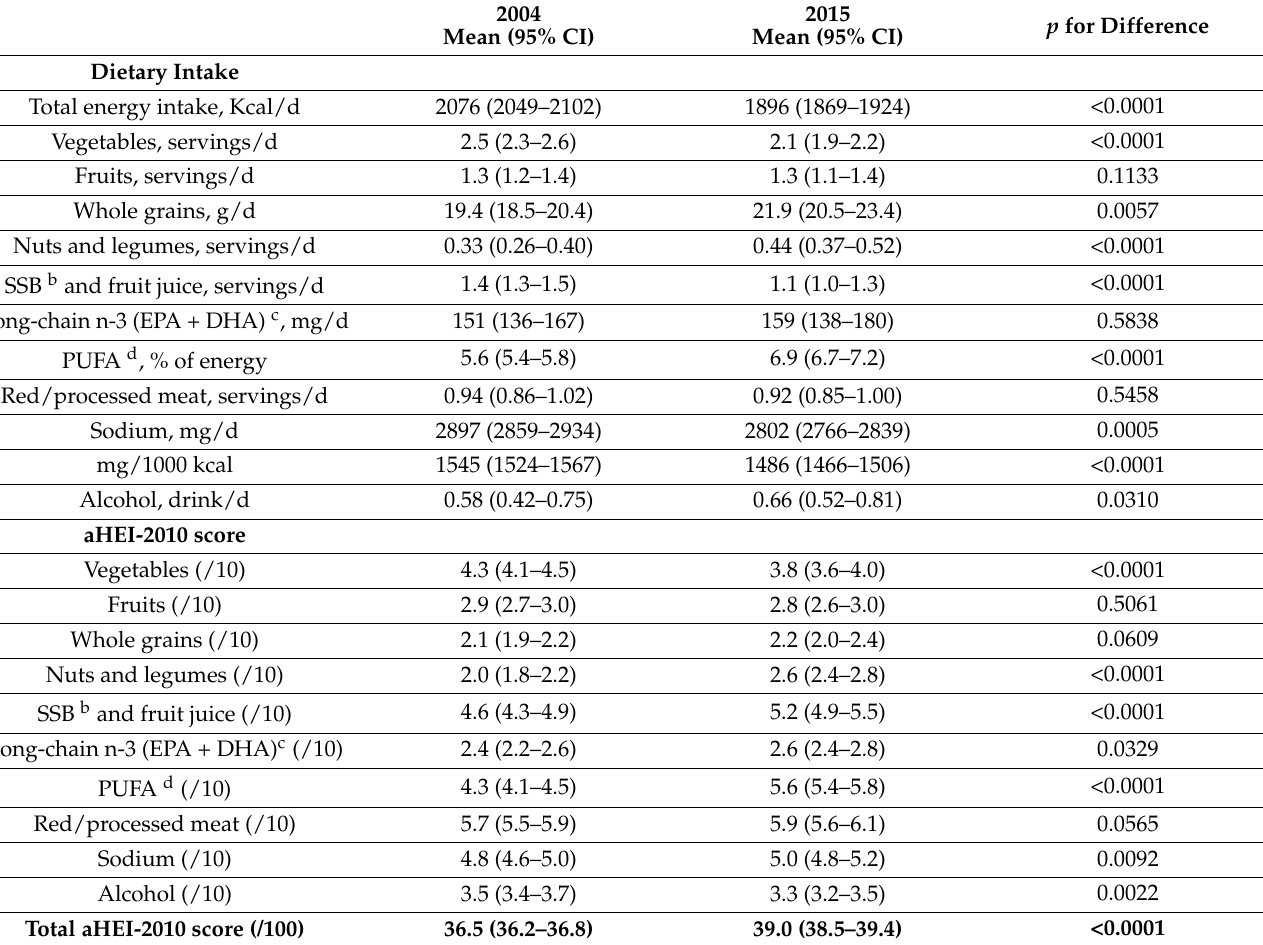
Table 2. Adjusted a mean dietary intake and alternate Healthy Eating Index 2010 (aHEI-2010) scores and 95% confidence intervals (95% CI) in adults from the Canadian Community Health Survey (CCHS)-Nutrition in 2004 and